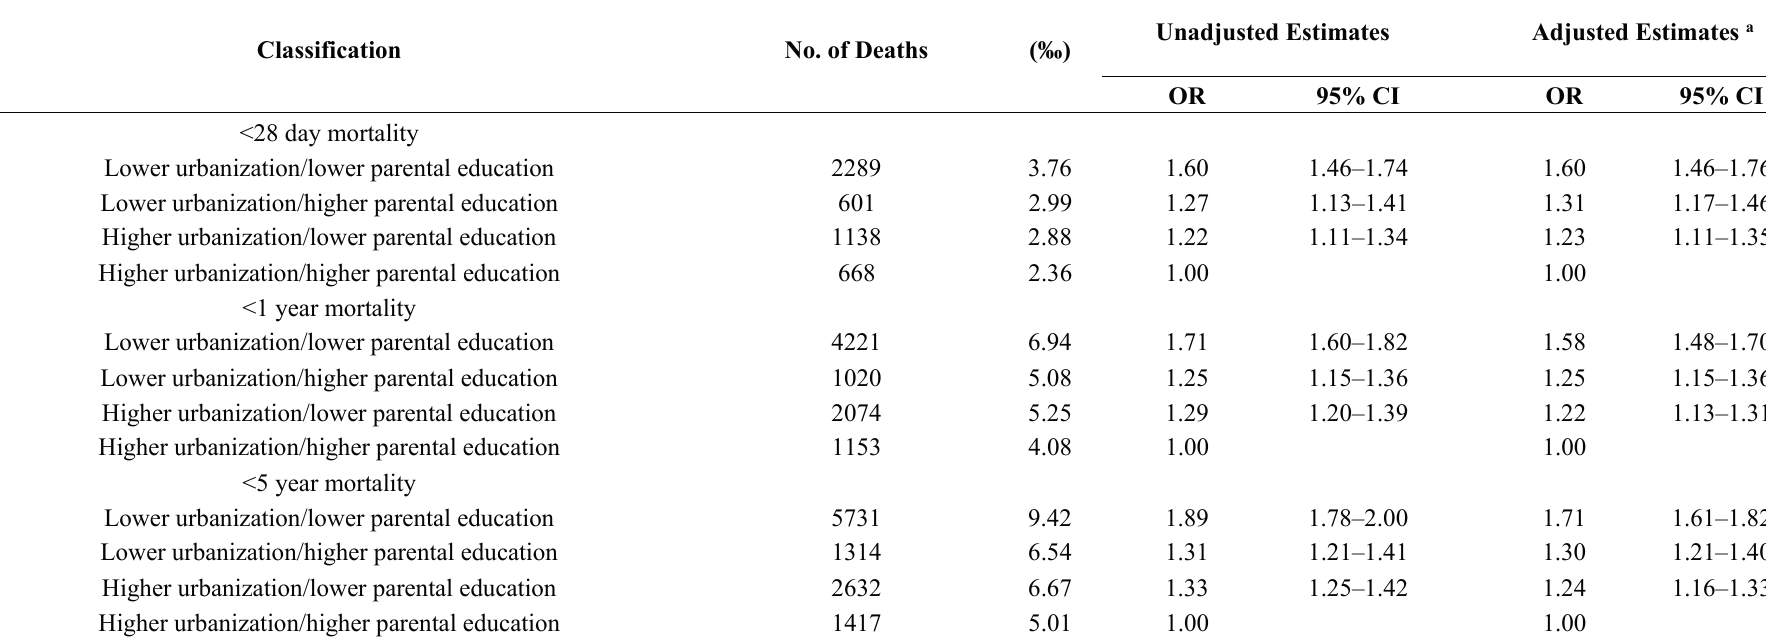
Table 3. Odds ratio of age-specific mortality according to classifications by urbanization and parental education. Classification No. of Deaths (‰)